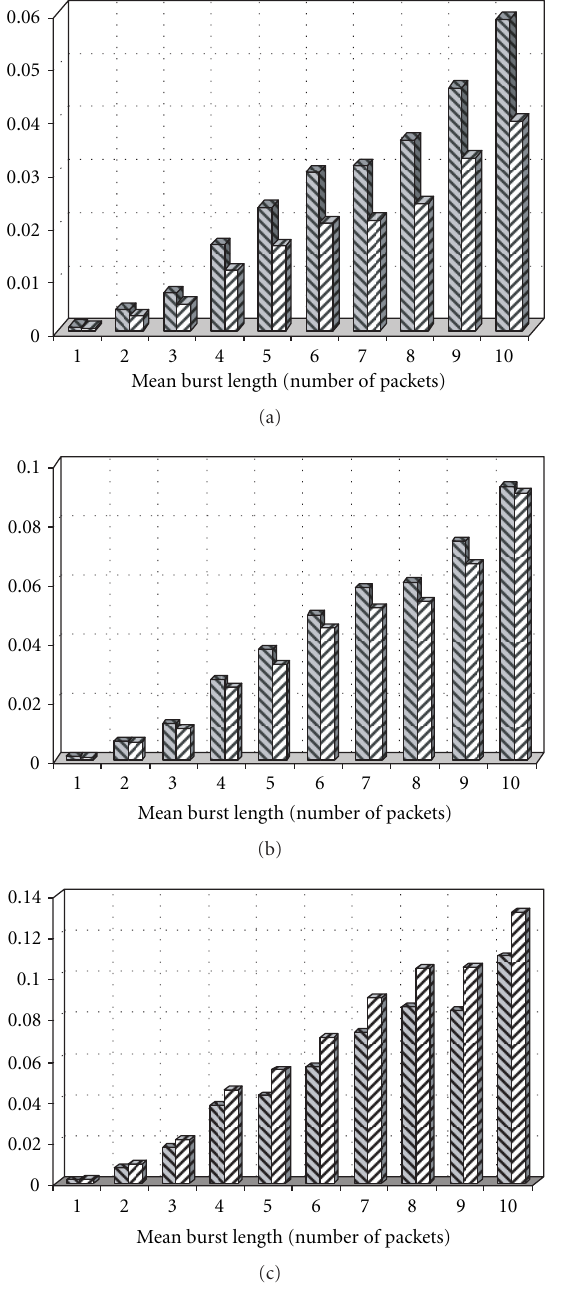
Figure 11: Ratio of packet losses between FEC interleaving (left- hand bars) without priority encoding and (right-hand bars) with priority encoding for (a) I-picture packets, (b) P-picture packets, and (c) B-picture packets.